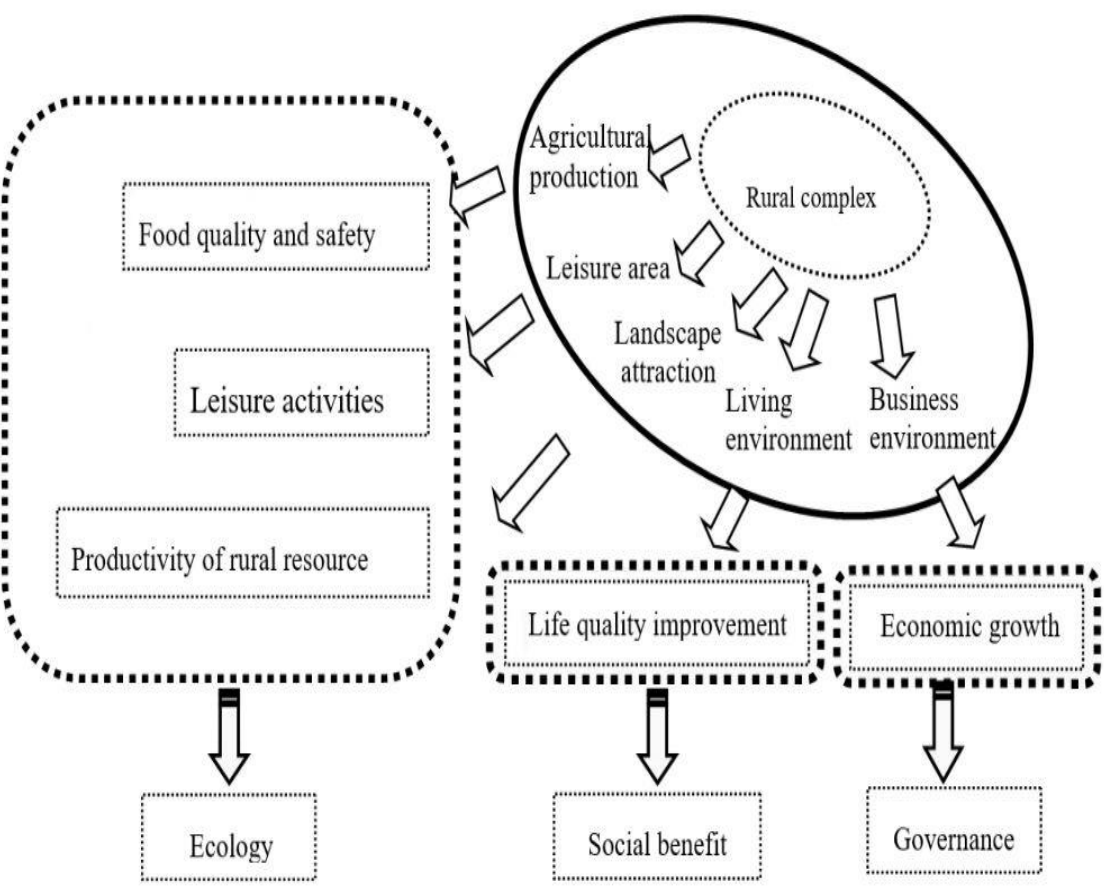
Figure 4. Functional framework of the rural complex. (Source: Drawn by the Authors).